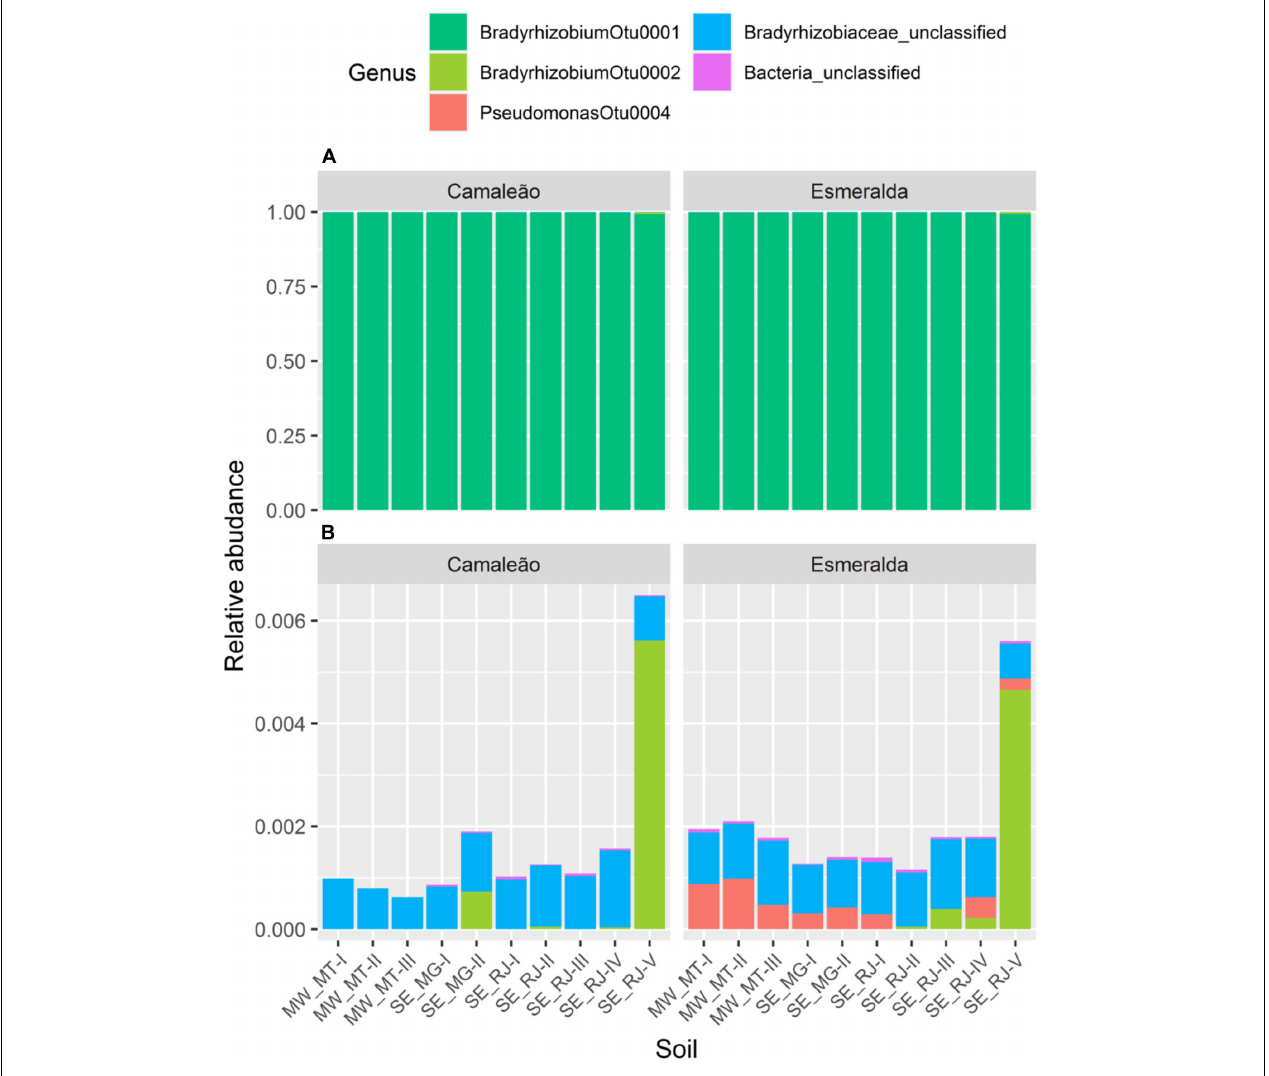
FIGURE 7 | Relative abundance of sequences based on the 16S rRNA gene from nodules of Camaleão and Esmeralda mung bean genotypes cultivated in 10 different soil samples: (A) relative abundance for all OTUs; and (B) for low abundance OTUs, after removal of OTU0001 ( Bradyrhizobium